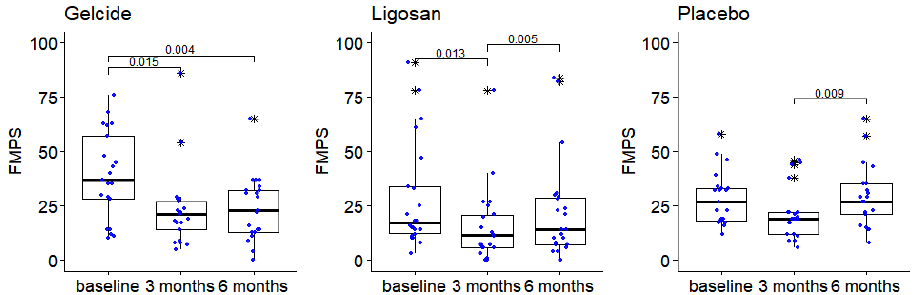
Figure 6. The evolution of the FMPS between successive time points in the three groups (numbers in brackets represent p -values of Wilcoxon tests for pairwise intragroup comparisons; p -values > 0.05 are not displayed), boxplot depicts median and interquartile range, large stars represent outliers; data points displayed as superimposed dot plots.